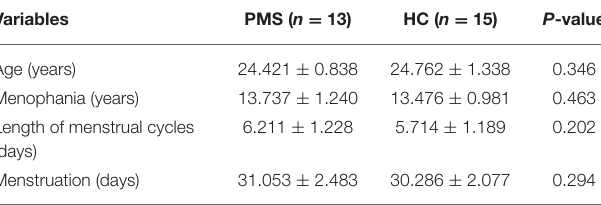
TABLE 1 | Demographics of PMS and HC groups.